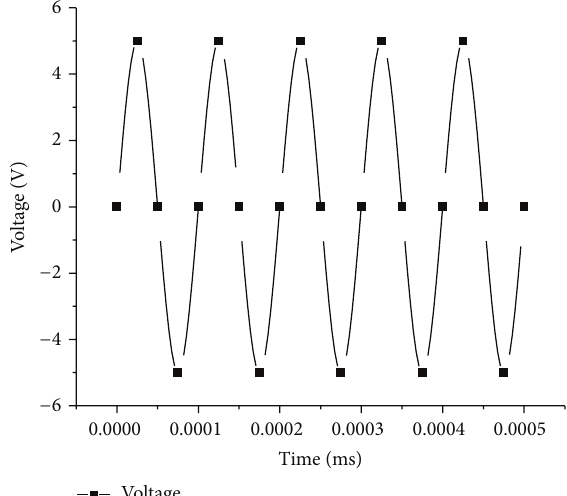
Figure 3: Input sinusoidal waveform applied to smaller cantilever beam.